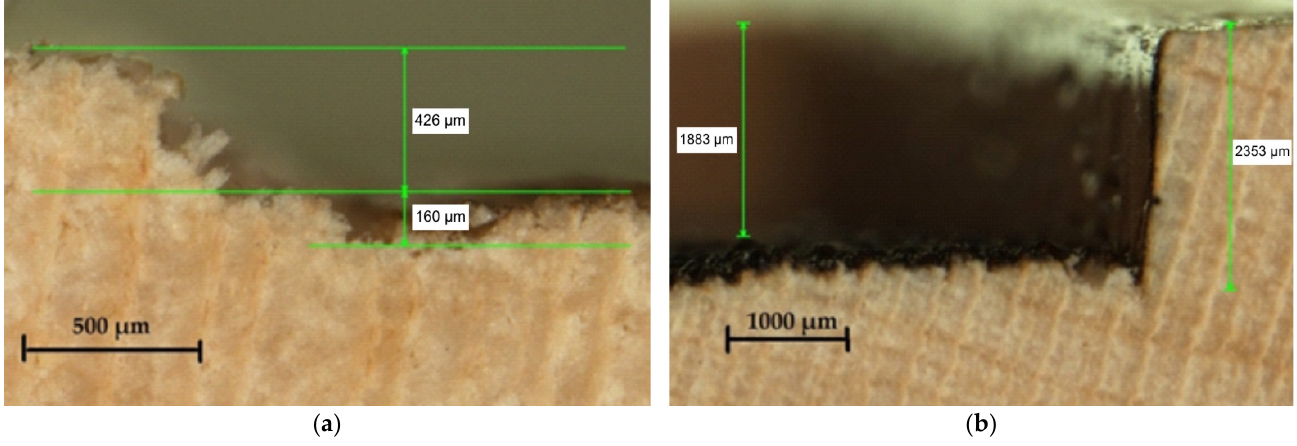
Figure 14. Measured wood burning depth for laser engraved surfaces: ( a ) With power of 20% of the maximum laser beam power of 150 W (90× magnification); ( b ) With power of 100% of the maximum laser beam power of 150 W (30× magnification).